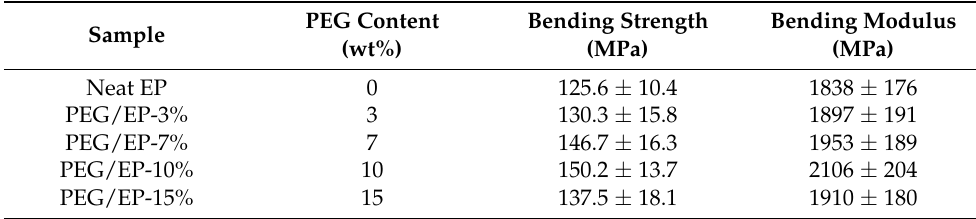
Table 1. Bending properties of the EP and PEG/EP composites with different PEG contents.